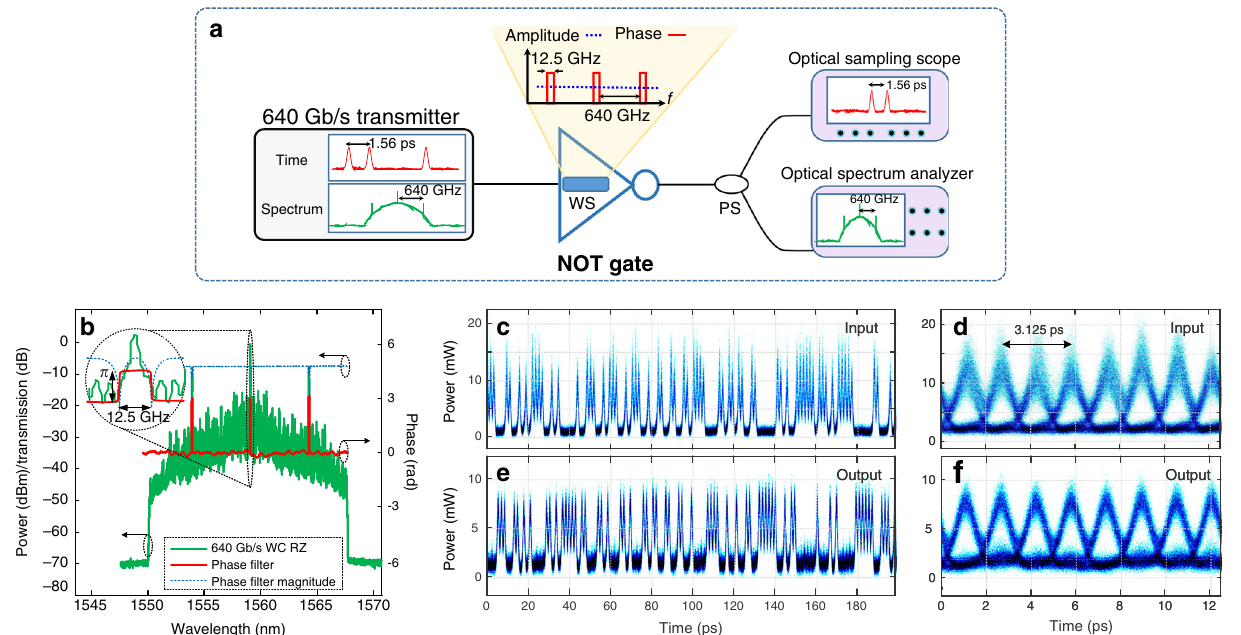
Fig. 4 Proof-of-concept demonstration of the frequency-domain zero switching-energy logic NOT gate. a Schematic of the experimental set-up. Arrangement consisting of a 640-GHz optical RZ data transmitter, the logic NOT gate, and a receiver to measure the temporal waveform and spectrum of the output signal. The logic NOT gate is implemented using an optical Waveshaper (WS) programmed to produce the needed phase-only linear fi ltering speci fi cations, i.e., a constant spectral amplitude and a spectral phase pro fi le with π phase shifts periodically spaced by 640 GHz and with each shift extending over a line-width of ~12.5 GHz (determined by the minimum frequency resolution of the WS). b Spectra of the coherent data signal input to and output of the logic gate (they are overlapped), as well as spectral phase pro fi le of the used phase fi lter (red). c , e Temporal traces of the 640 Gbit/s coherent digital input data signal ( c ) and the inverted output data signal ( e , synchronized with respect to the input for representation purposes). d , f Eye diagram (overlapping the temporal signals over eight consecutive bit time periods) corresponding to the input and output data signals shown in plots c and e ,